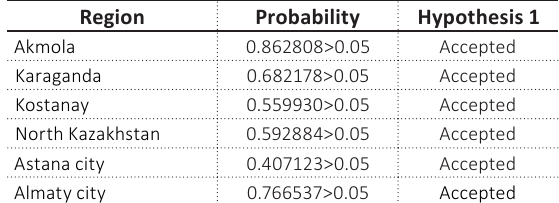
Table 5. Estimated indicators of the normal distribution of balances by regions of Kazakhstan for